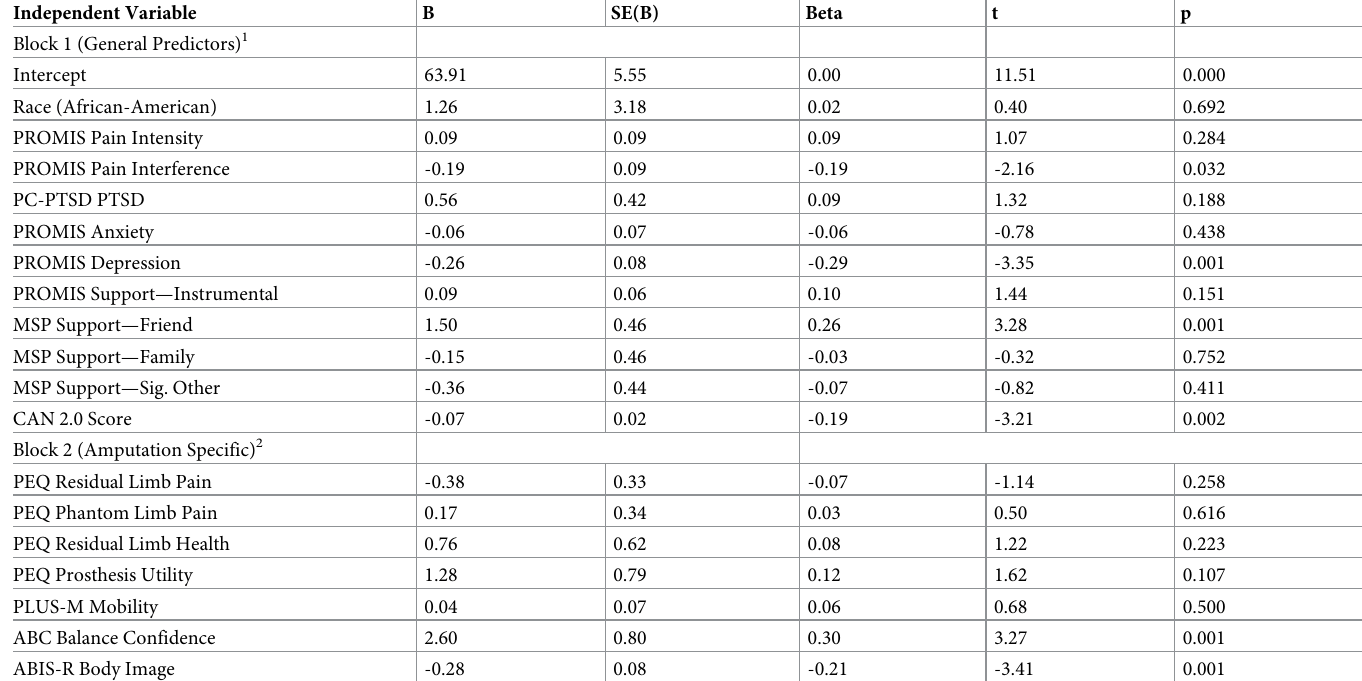
Table 8. Regression of PROMIS satisfaction on general and specific